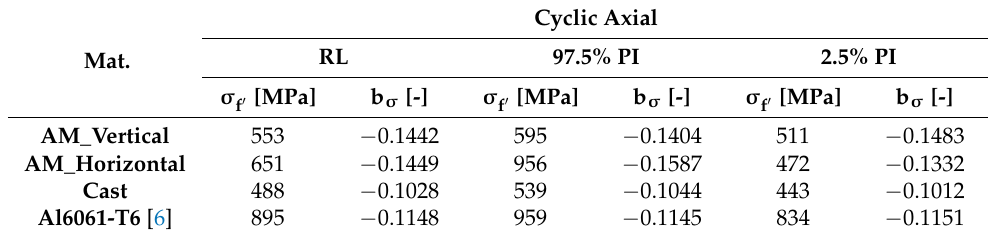
Table 4. Cyclic material parameters.